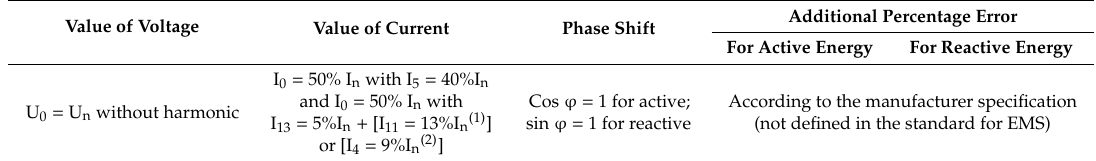
Additional Percentage Error